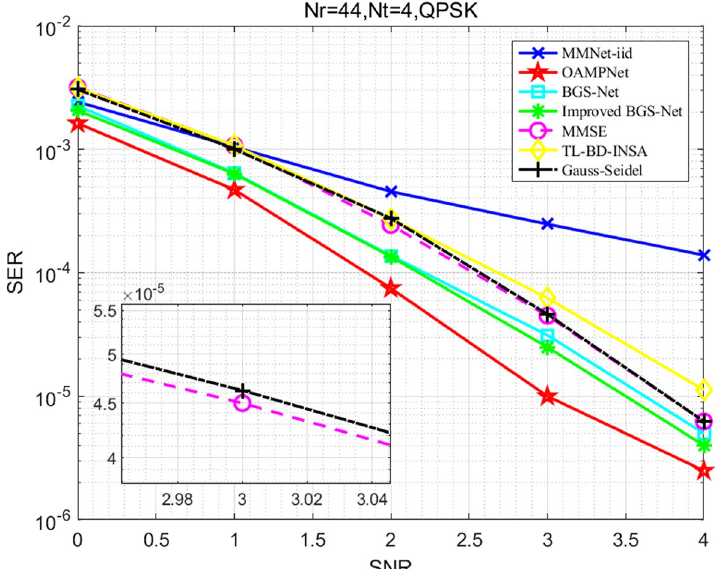
Fig. 19 SER performance comparison of different algorithms for N t = 4,N r = 44 , QPSK, MAUE system with ξ r = 0, ξ t =